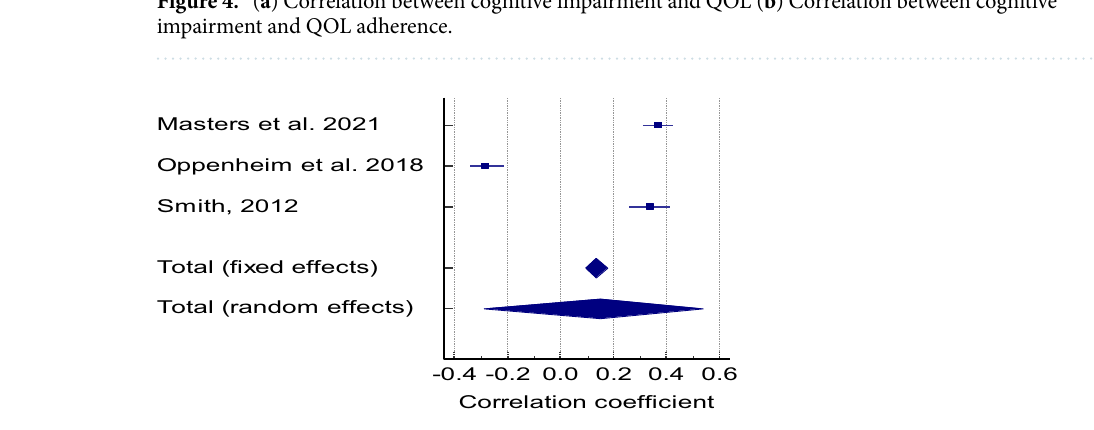
Figure 5. Correlation between cognitive function/impairment and